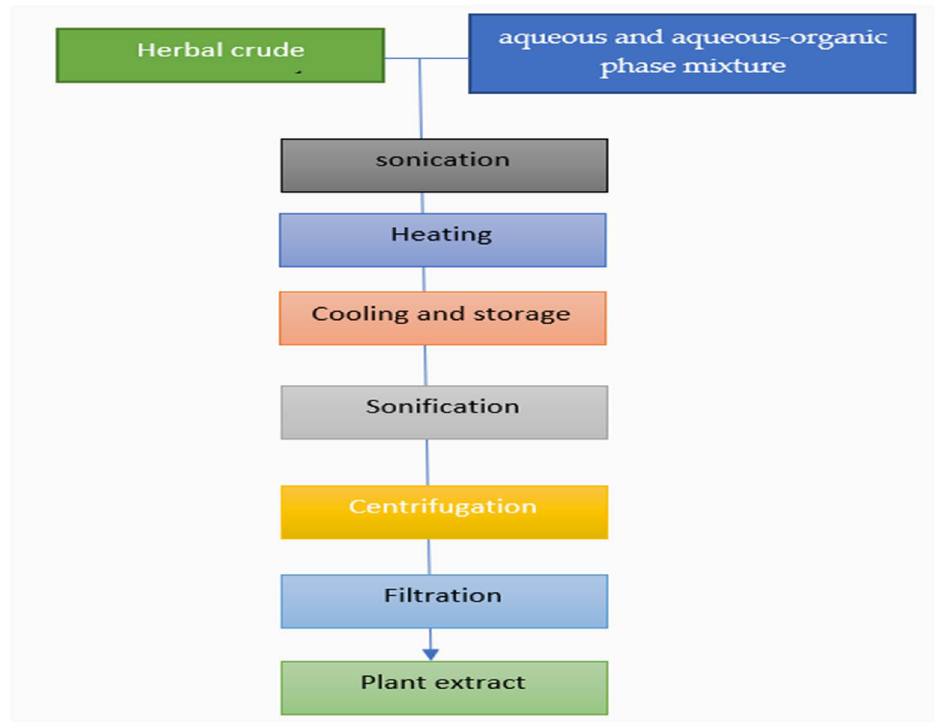
Figure 4. The schematic representation for the aqueous and aqueous-organic phase extraction prep- aration of the medical plants in